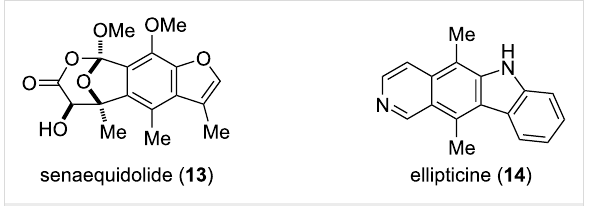
Figure 1: Structure of senaequidolide ( 13 ) and ellipticine ( 14